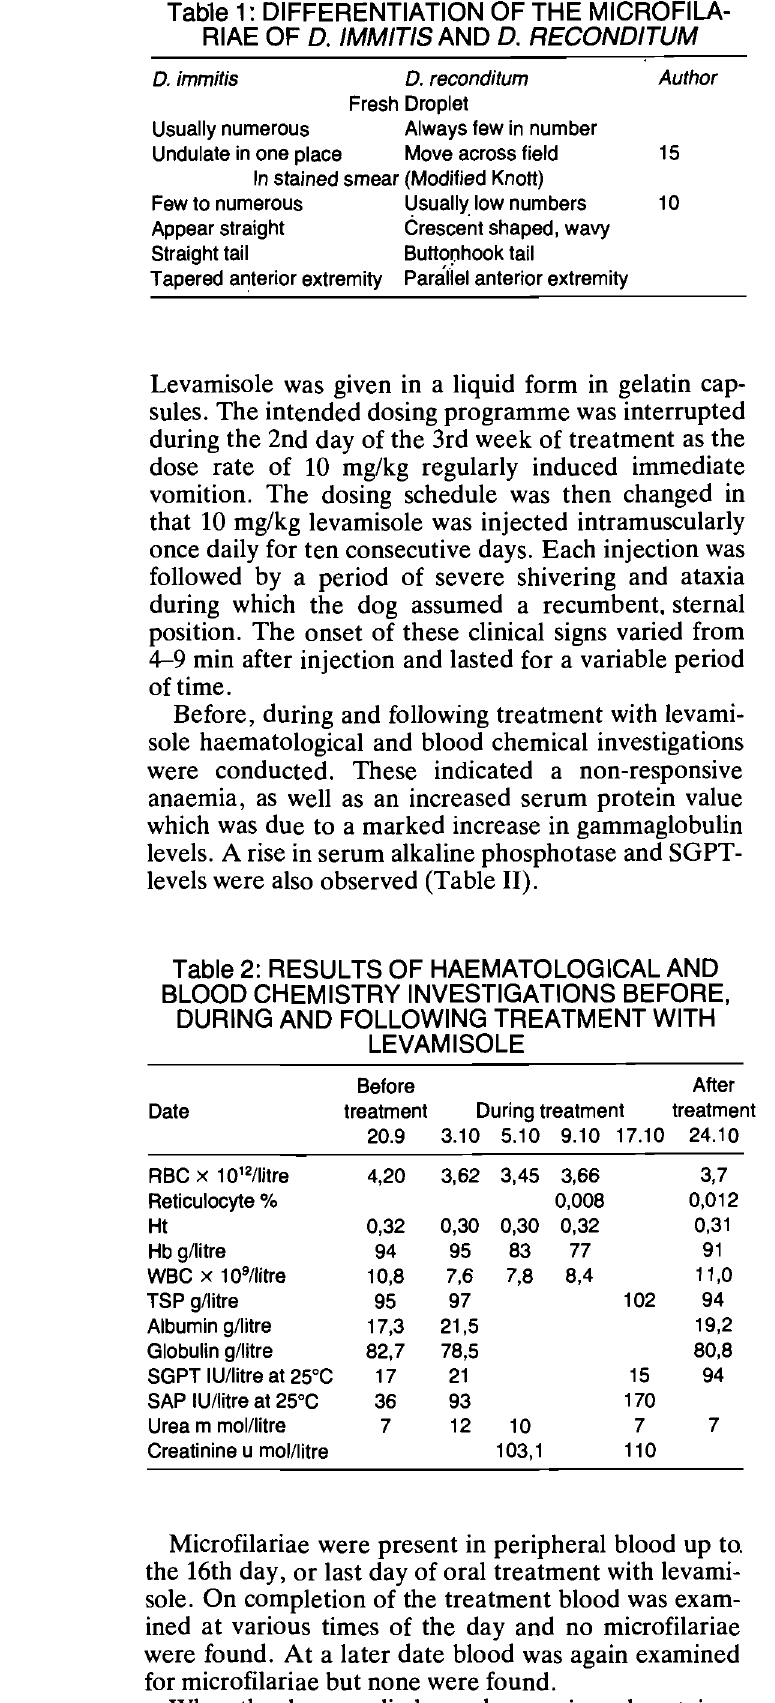
Table 1: DIFFERENTIATION OF THE MICROFILA